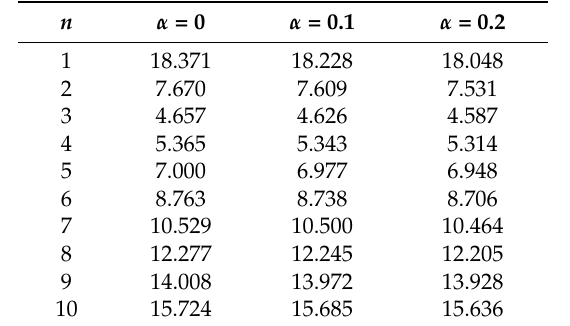
Table 8. Variation of the natural frequency ω (GHz) against circumferential wave number n for different porosity volume fractions α of FGPM-I nanoshell (C-C). n